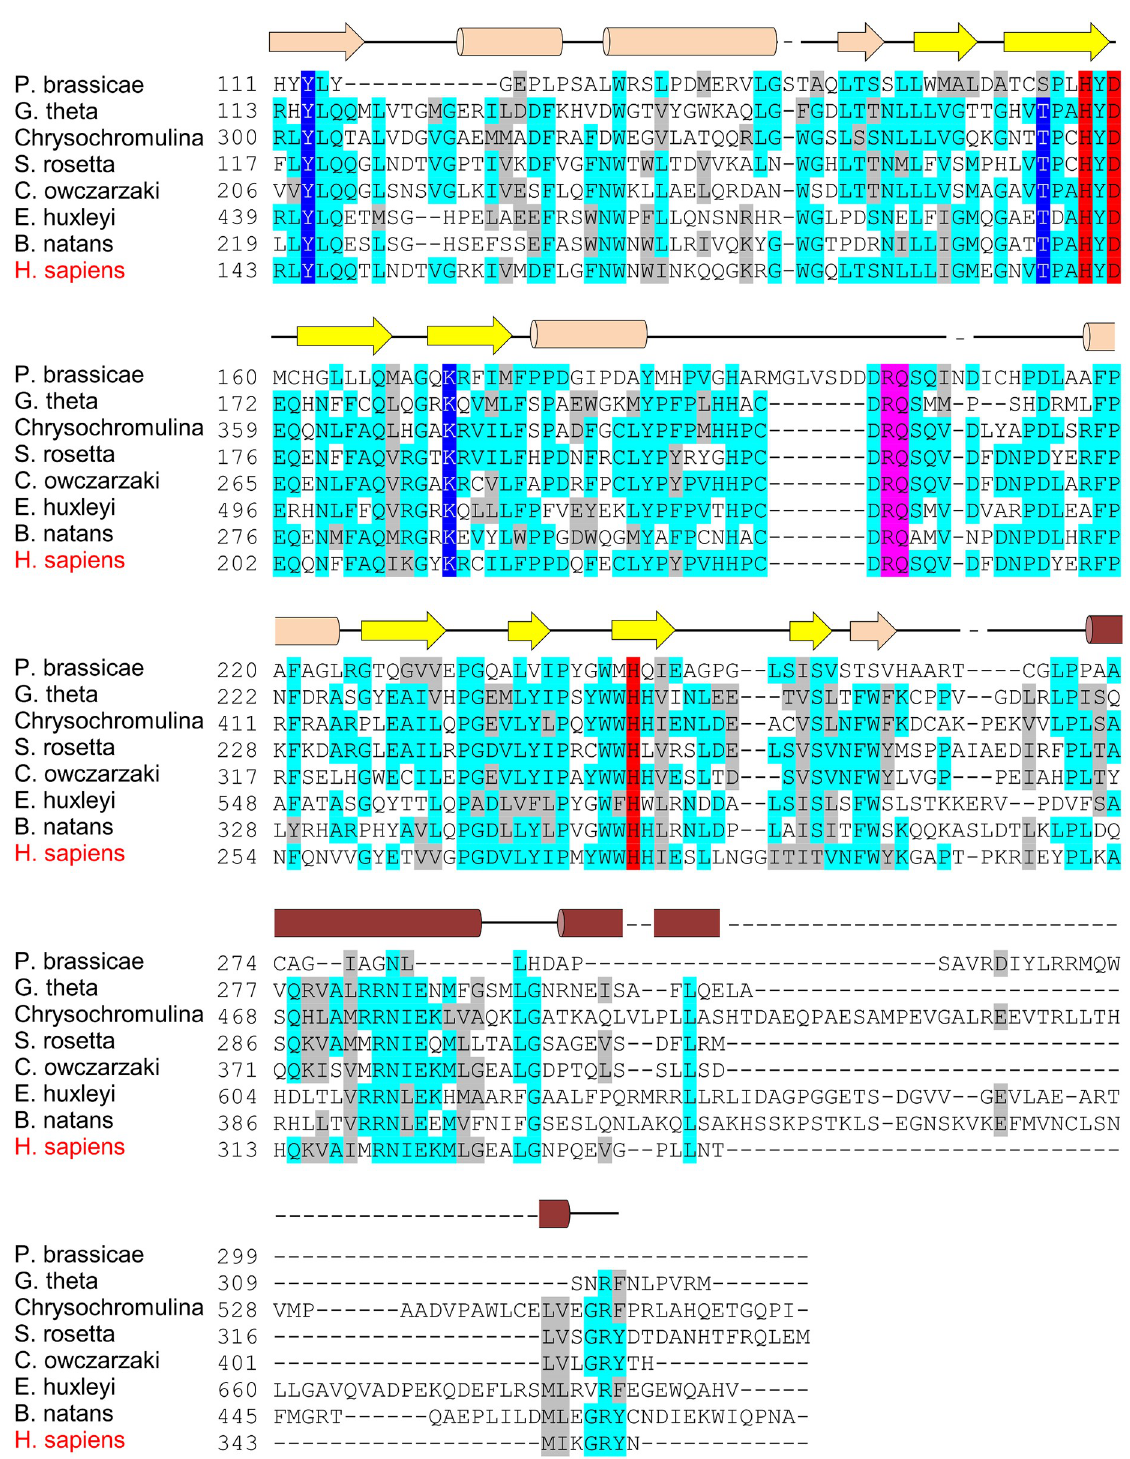
Fig 5. Alignment of putative premetazoan FIH homologs with human FIH. The sequences of FIH homologs C-terminal to the first 2-OG- binding residue (Tyr145 in hsFIH) were aligned using Clustal Omega [51]. Residues strongly or partially conserved are shown with cyan and grey highlights, respectively. Residues involved in iron coordination (red), 2-OG binding (dark blue), and target asparagine positioning (pink) are indicated. The secondary structure of hsFIH is depicted above the alignment, with yellow arrows indicating the beta strands which make up the double-stranded β -helix (DSBH), and dark brown helices denoting those involved in dimerisation. Amino acid numbers are